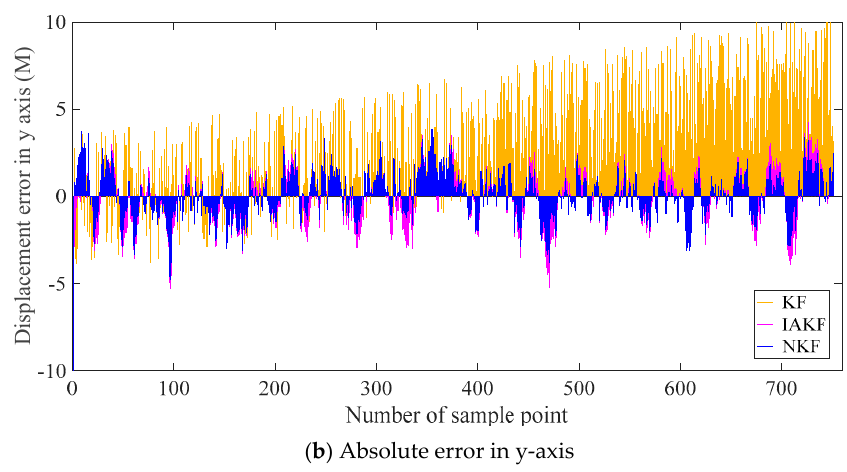
Figure 12. Absolute errors of displacement in x and y axes.